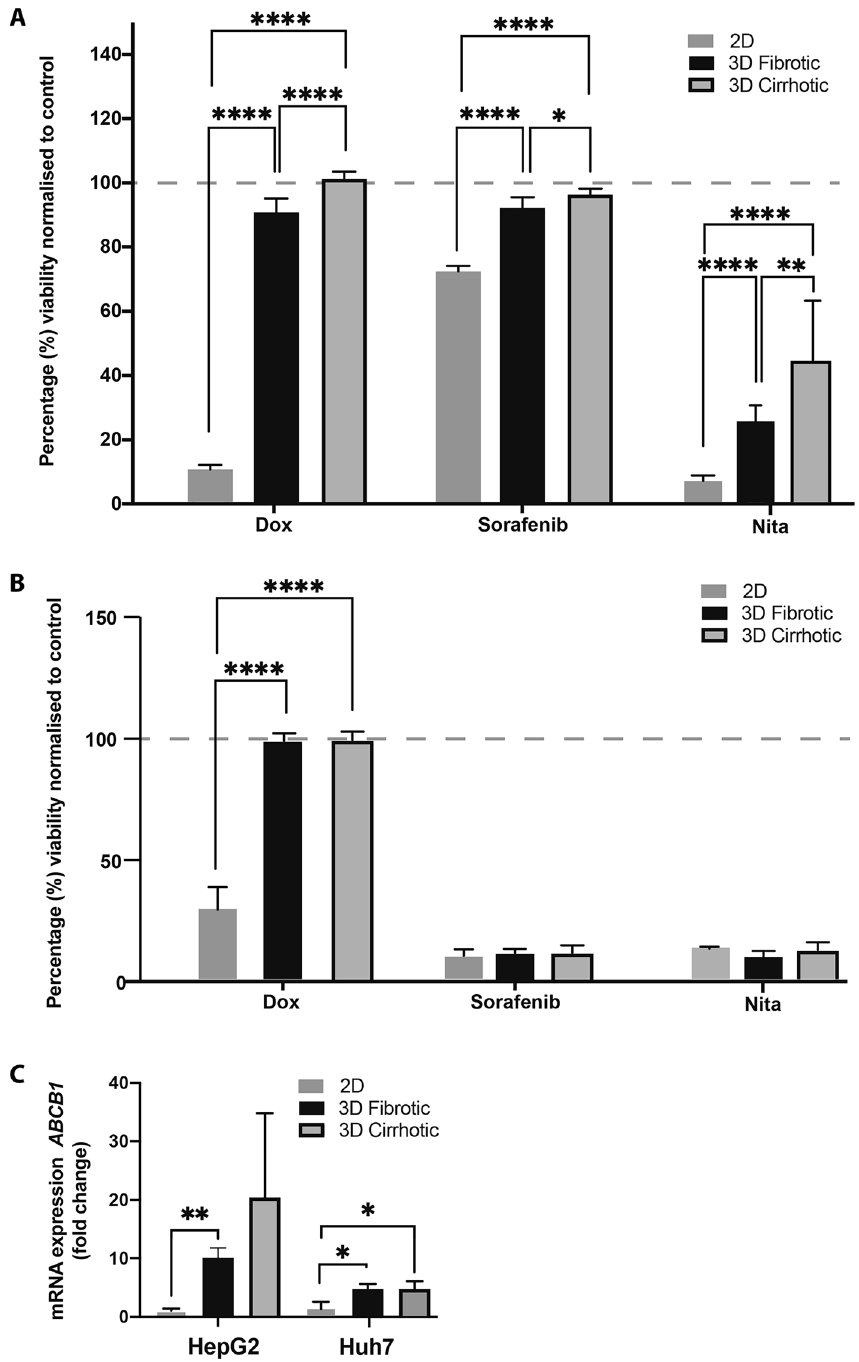
Figure 5. Effect of microenvironment on drug response to doxorubicin, sorafenib and nitazoxanide. ( A ) Percentage cell viability of HepG2 cells grown in 2D and 3D 96 h after treatment with Doxorubicin (1 µM), sorafenib or Nitazoxinide (10 µM). ( B ) Percentage cell viability of Huh7 cells grown in 2D and 3D 96 h after treatment with Doxorubicin (1 µM), sorafenib or Nitazoxinide (10 µM). ( C ) mRNA expression of ABCB1 in HepG2 and Huh7 cells grown in 2D and 3D. All values are normalised to the respective untreated control groups. (n = 3, error bars = SD, *p < 0.05, **p < 0.01, ***p < 0.001, ****p <